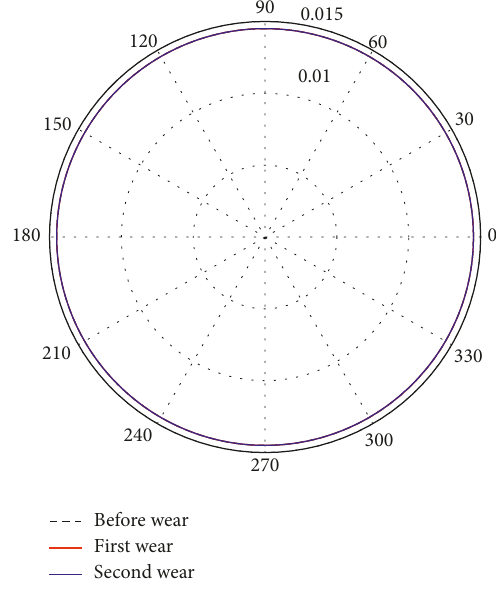
Figure 8: Shaft surface of joint B .